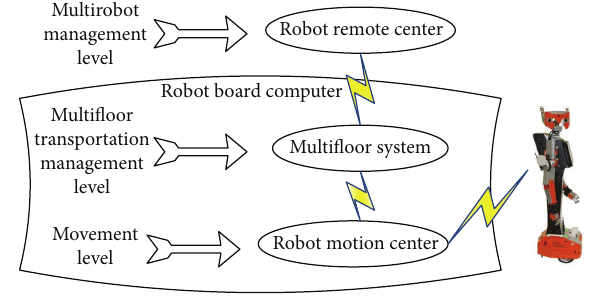
Figure 1: System